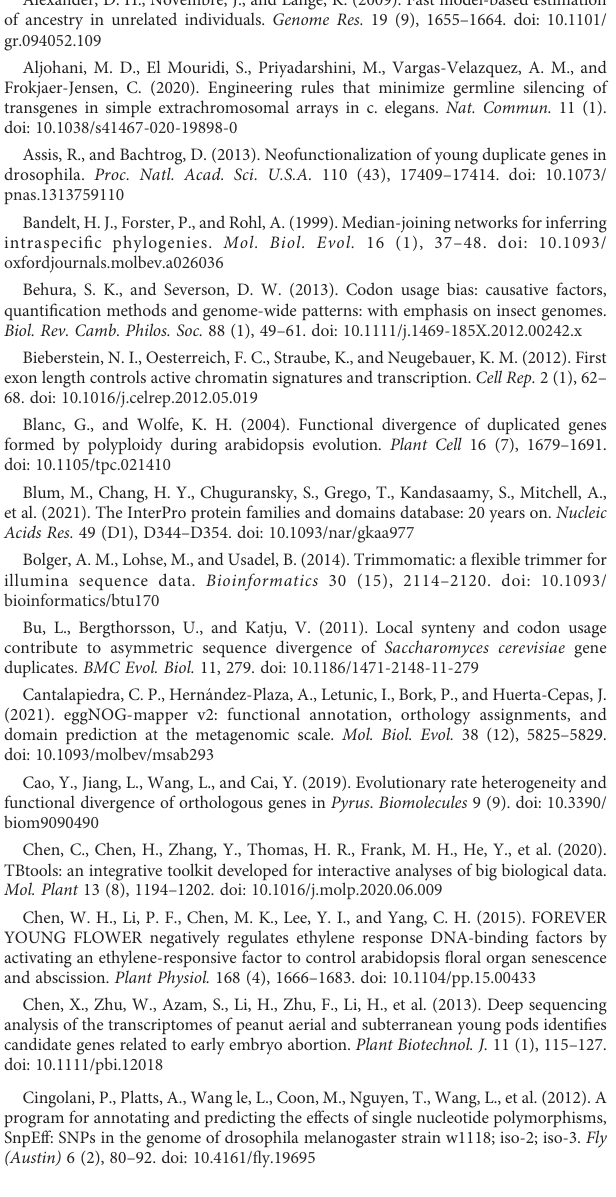
SUPPLEMENTARY FIGURE 11 GO enrichment analysis of non-expanded genes. The top 10 GO enrichment terms are displayed for each category. SUPPLEMENTARY FIGURE 12 KEGG pathway enrichment analysis of non-expanded genes. SUPPLEMENTARY FIGURE 13 PO enrichment analysis of non-expanded genes. SUPPLEMENTARY FIGURE 14 Expression pattern of differentially expressed expanded genes. Detailed annotation of tissues/stages is the same as. SUPPLEMENTARY FIGURE 15 Expression pattern of NBS-LRR s in different tissues/stages. Detailed annotation of tissues/stages is the same as.